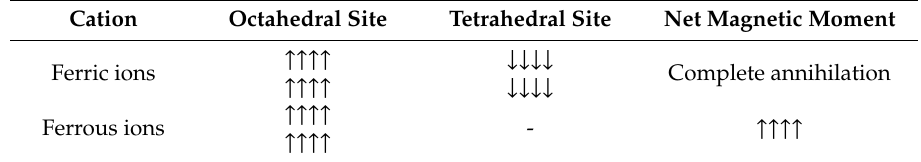
Table 1. Spin magnetic moment distribution of Fe 3 + and Fe 2 + ions in Fe 3 O 4 elemental cell [26]. Cation